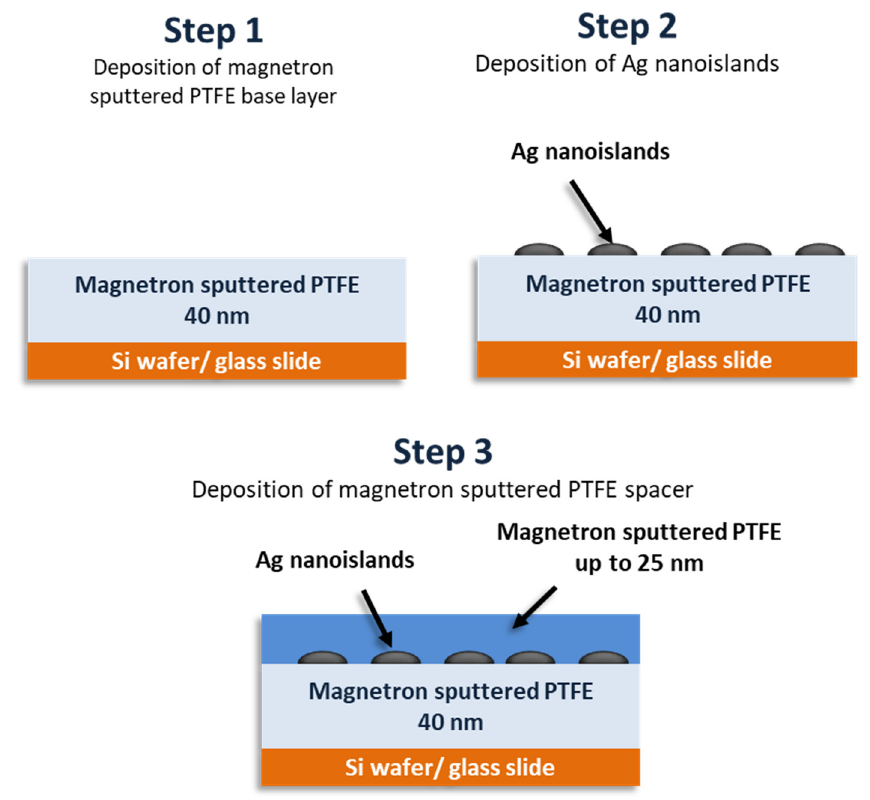
Figure 2. Three-step deposition of surface-enhanced fluorescence (SEF) nanostructures.